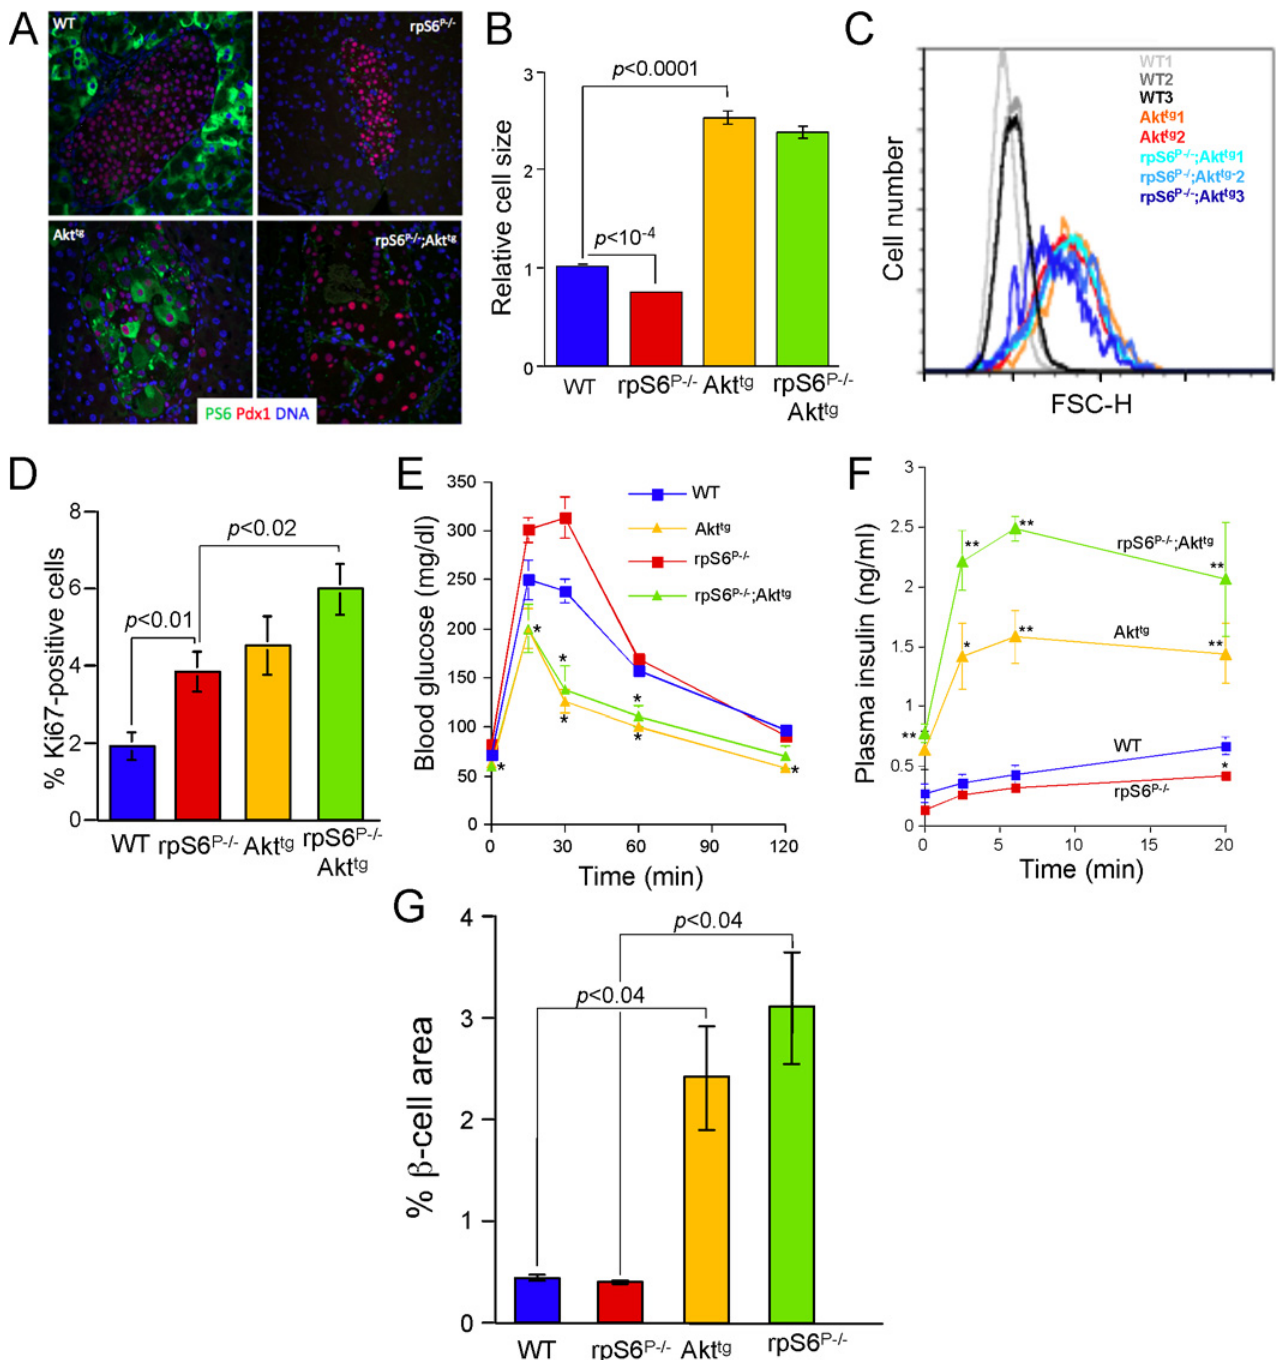
Fig 1. Akt overexpression overrides the inhibitory effect of rpS6 knockin on β -cell size and function. (A) Representative images of β -cells of all four genotypes. Pancreatic sections for WT, rpS6 P-/- , Akt tg and Akt tg ; rpS6 P-/- 2-month-old mice were immunostained for phospho-rpS6 (green), for Pdx1 (red) and for DNA by Sytox (blue). All images are set to the same scale. (B) Pancreatic sections from 2-month-old mice were stained for DNA by Sytox and for β -cells cytoplasm by anti-insulin antibodies. The size of β -cells was derived from the reciprocal value of their density, which represents the number of nuclei in multiple 2,500- μ m 2 squares that contained only insulin-positive cells. The relative cell size was attained by normalizing to that of wild type mice, arbitrarily set at 1. Values are presented as a mean ± SEM of counts derived from 121 to 189 squares within 21 to 31 islets identified in 3 to 6 mice of each genotype. (C) β - cells were isolated from 2-month-old mice (three wild-type (WT), two Akt tg and three rpS6 P-/- ;Akt tg mice), fixed, permeabilized, immunostained for insulin, HA, Ki67 and Hoechst before FACS analysis. The cell size of quiescent β -cells (HA- and insulin-positive, Ki67-negative) was measured as described in Material